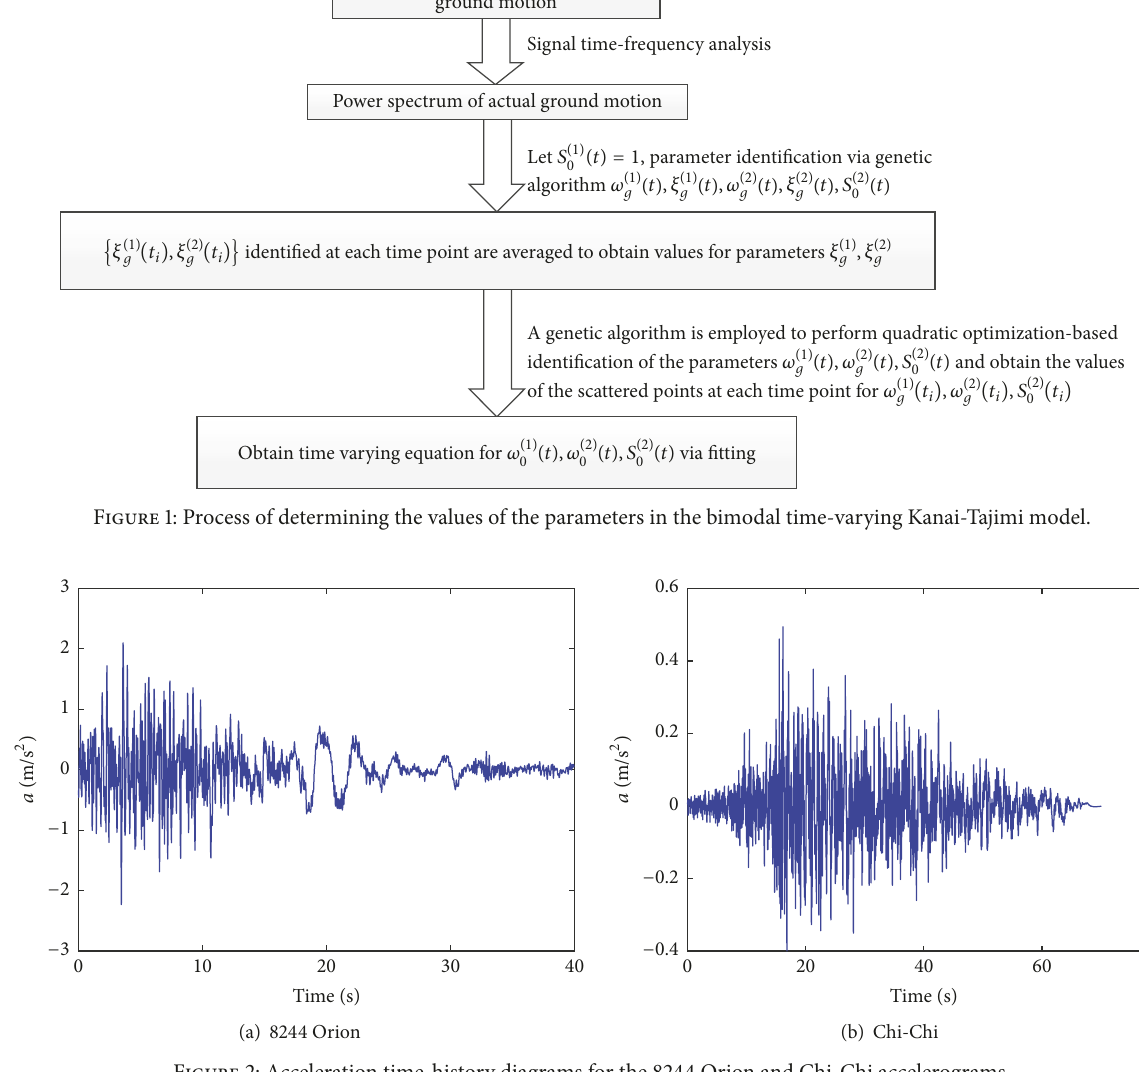
Figure 2: Acceleration time-history diagrams for the 8244 Orion and Chi-Chi